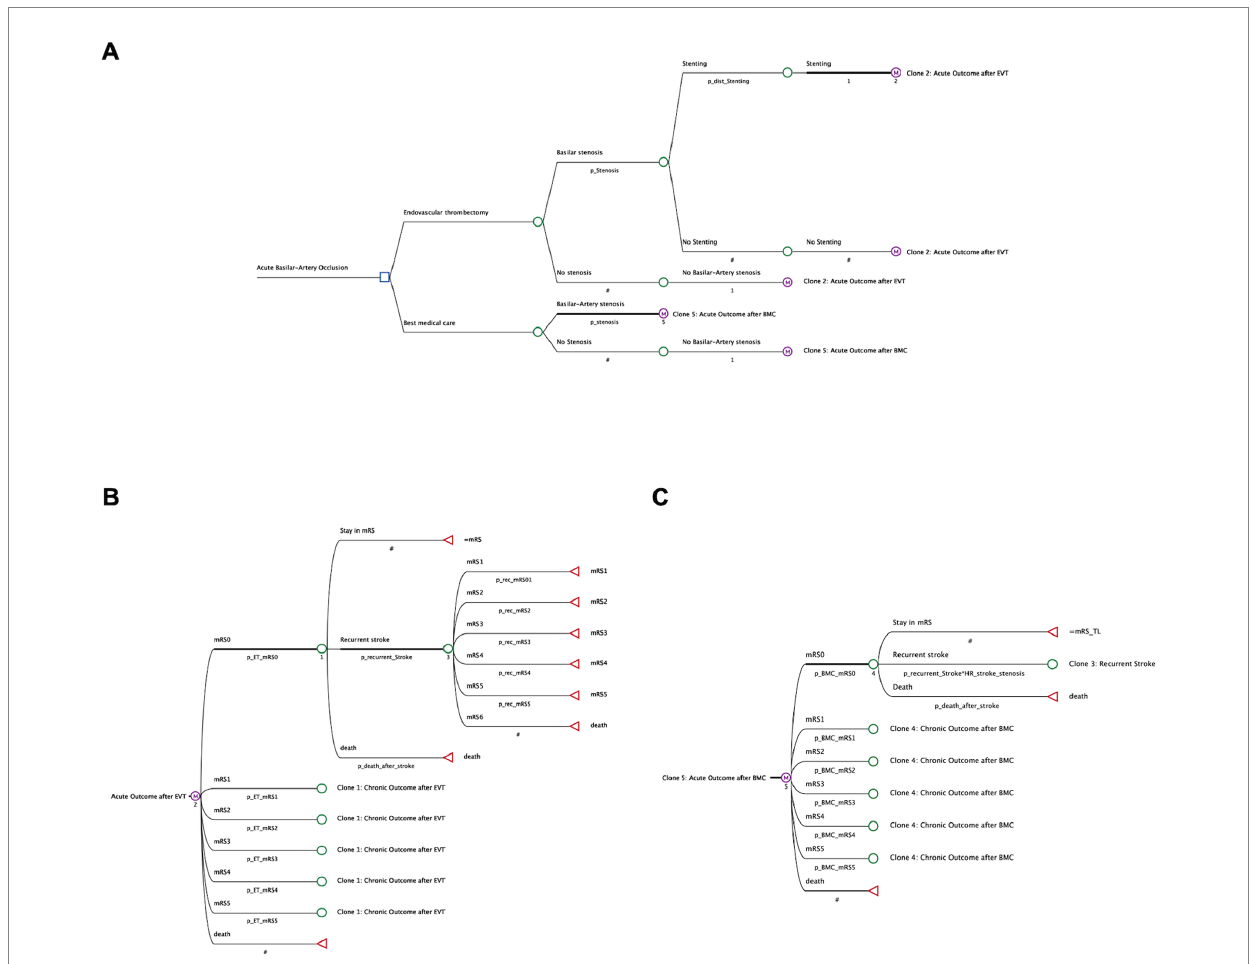
FIGURE 1 Structure of decision tree and markov-model. (A) Patients with acute basilar artery occlusion received either best medical care (BMC) or endovascular thrombectomy (EVT). Patients were then differentiated according to underlying basilar stenosis and stent implantation. The adjacent Markov model simulates lifelong pathways of stroke patients with a possible level of disability, according to the clinical outcomes reported after EVT (B) or BMC (C) . Costs and effectiveness (QALYs) are compared for both treatment